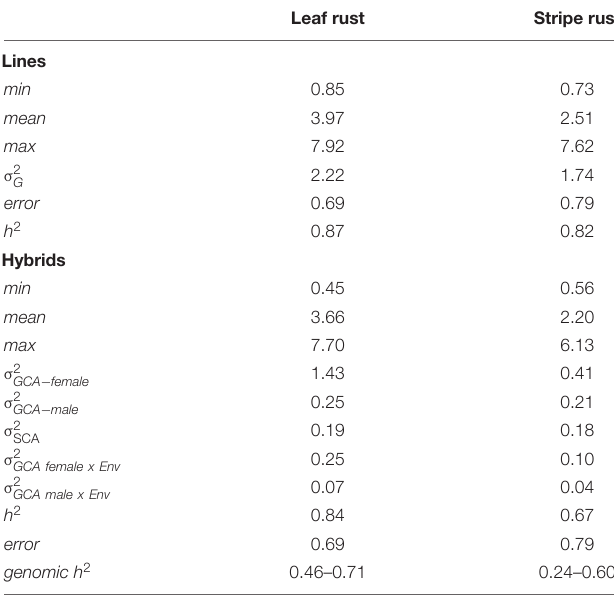
Leaf rust Stripe rust